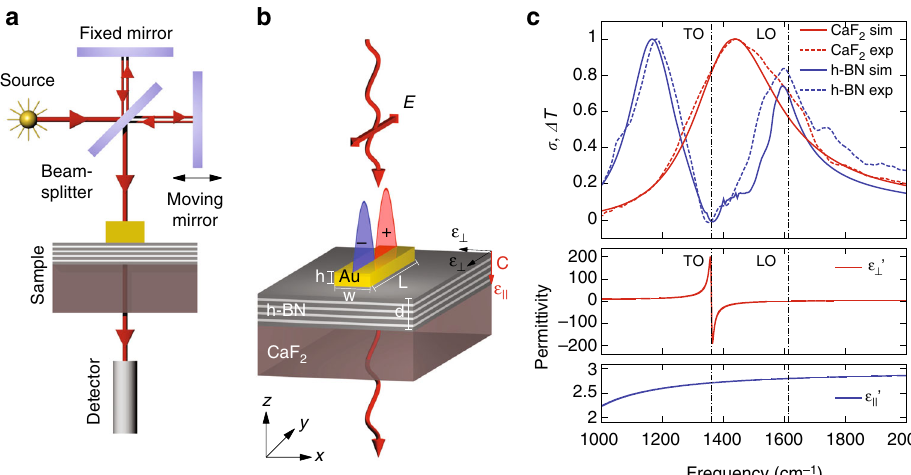
Fig. 1 Infrared spectroscopy of gold rod antennas on top of an h-BN fl ake. a Schematics of the setup for the spectral far- fi eld transmission measurements. b Schematics of the sample, illuminated by an incident plane wave: the gold rod antenna on top of the fl ake of h-BN placed on the CaF 2 substrate. The optical axis, C, and the dielectric permittivity tensor components, ϵ ⊥ and ϵ ║ , are indicated by the red and black arrows. c Top: normalized measured difference transmission spectra (dashed curves) and simulated extinction spectra (solid curves) for the antenna ( L = 2.29 μ m, w = 175 nm, and h = 50 nm) on CaF 2 (red curves) and on h-BN ( d = 55 nm)/CaF 2 (blue curves). Bottom: real part of the perpendicular (red curve) and parallel (blue curve) components of the dielectric permittivity of h-BN as a function of frequency. Vertical dashed lines mark the positions of LO and TO